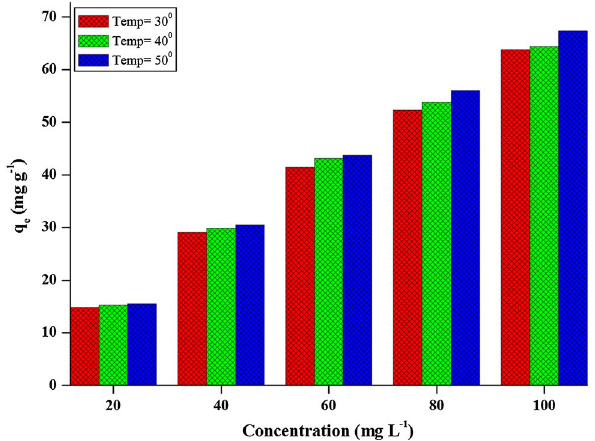
Fig. 11 Effect of initial dye concentration on the adsorption of CV onto PGADP (conditions; pH = 7.3; adsorbent = 0.025 g; contact time = 180